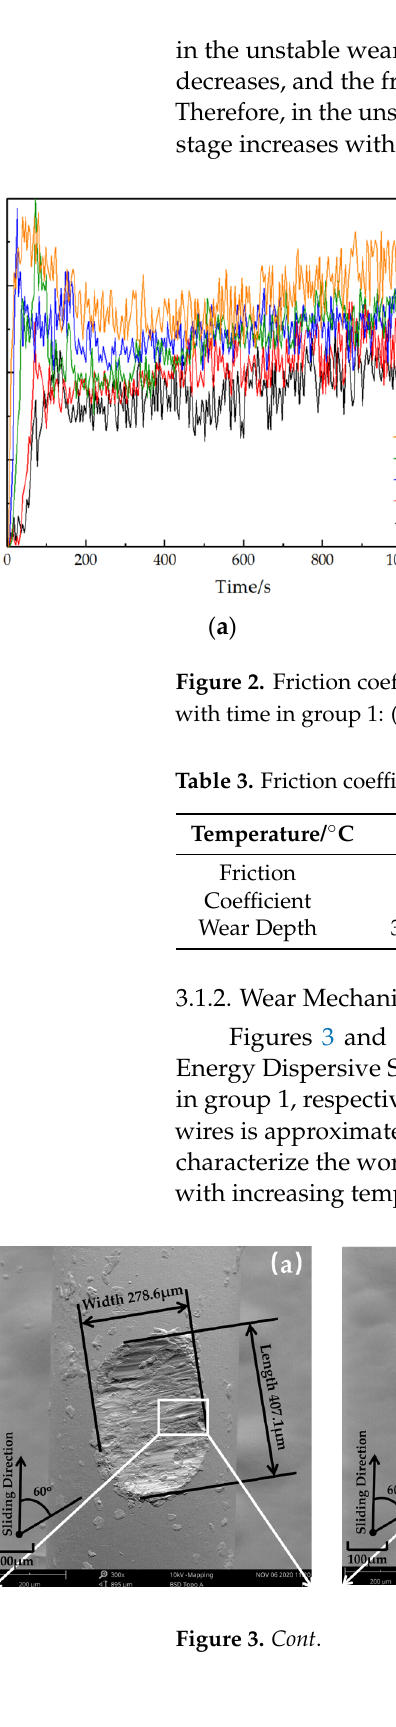
Table 3. Friction coefficient and wear depth of 316L stainless steel in group 1.